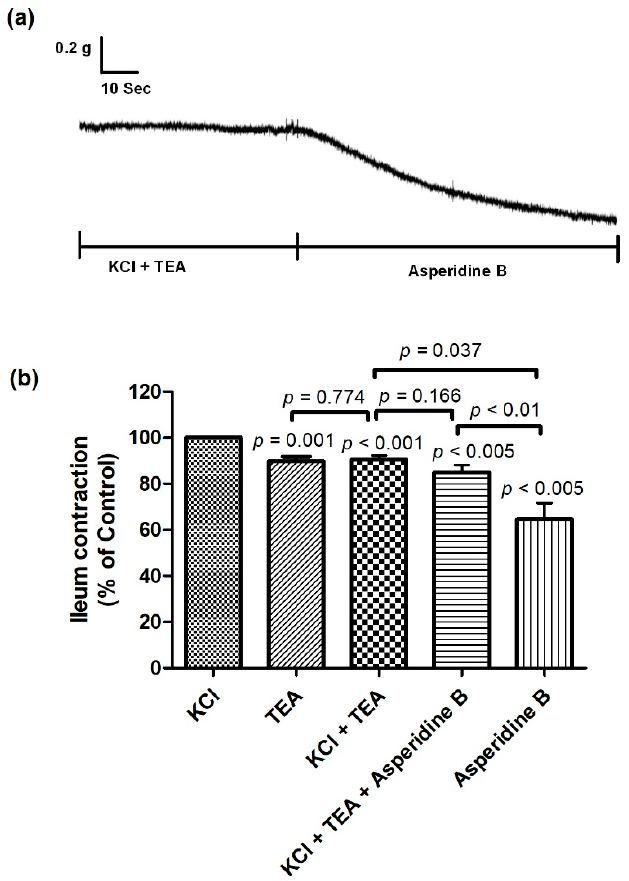
Figure 5. ( a ) Representative tracing and ( b ) effect of asperidine B on rat’s ileum contractions induced by KCl in the absence or presence of TEA ( n = 5–6). The differences of the tested compounds, except specific comparator, indicated that it compared with KCl.